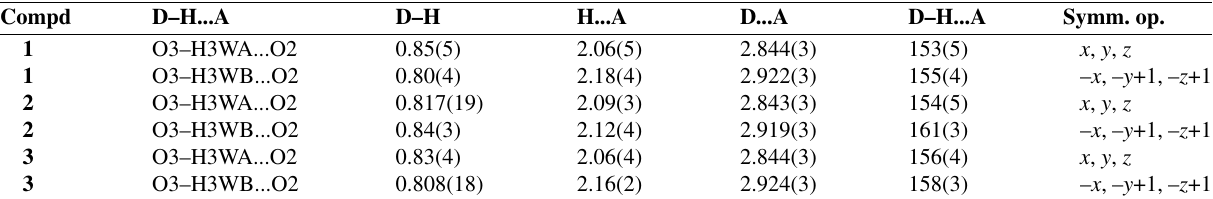
Table 3. Details on hydrogen bonding geometry (Å, °) in dihydrates 1–3 .